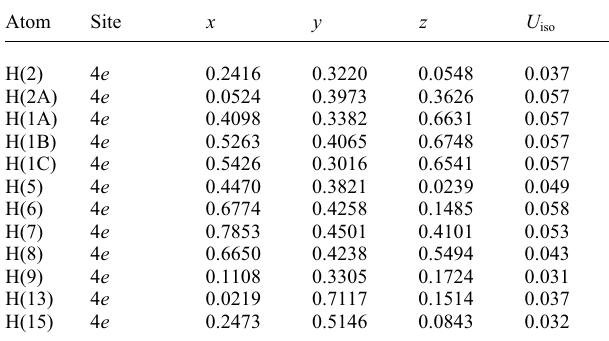
Table 2. Atomic coordinates and displacement parameters (in Å 2 ) .